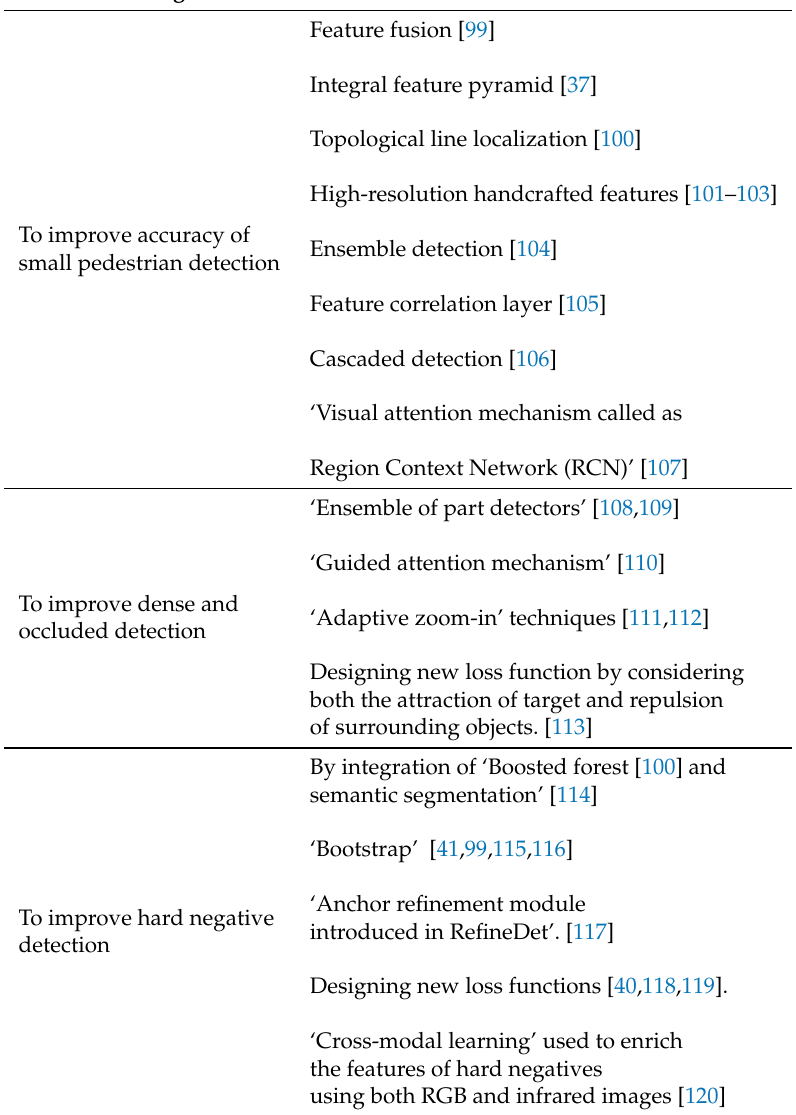
Table 8. Remedies to improve challenges arising in pedestrian